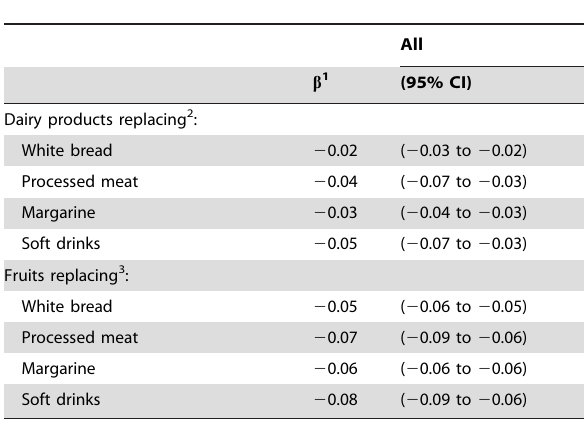
Table 3 . Estimated annual change in ‘‘waist circumference for a given body mass index ( D WC BMI , cm/y)’’ observed when 100 kcal of fruits or 100 kcal of dairy products replaced 100 kcal of white bread, processed meat, margarine, or soft drinks (analyses conducted in men and women combined).